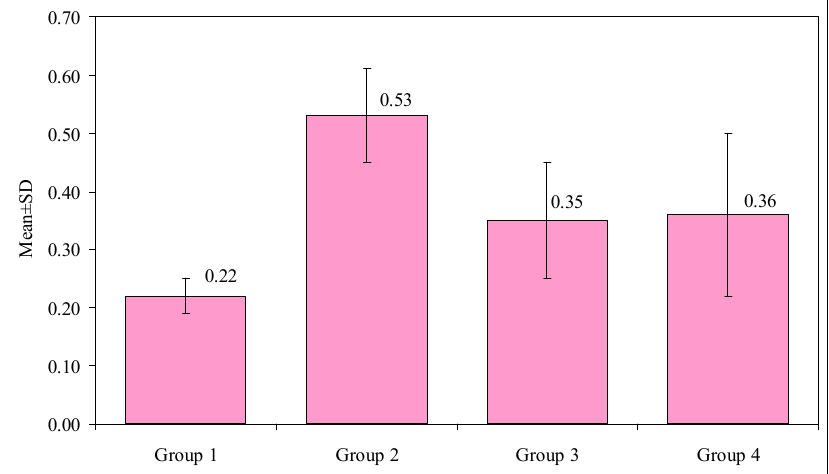
Figure 5. Comparison of mean values of the tensile strengths in Groups 1–4. Group 1: Control; Group 2: Treated with Gluma dentin desensitizer; Group 3: treated with Telio CS desensitizer; Group 4: Treated with Shield Force Plus desensitizer.